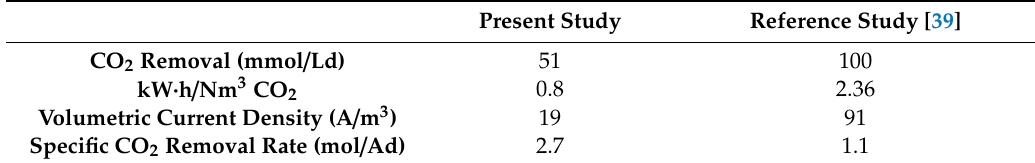
Table 5. Performance comparison of the tubular MEC and previous literature data for the cathodic CO 2